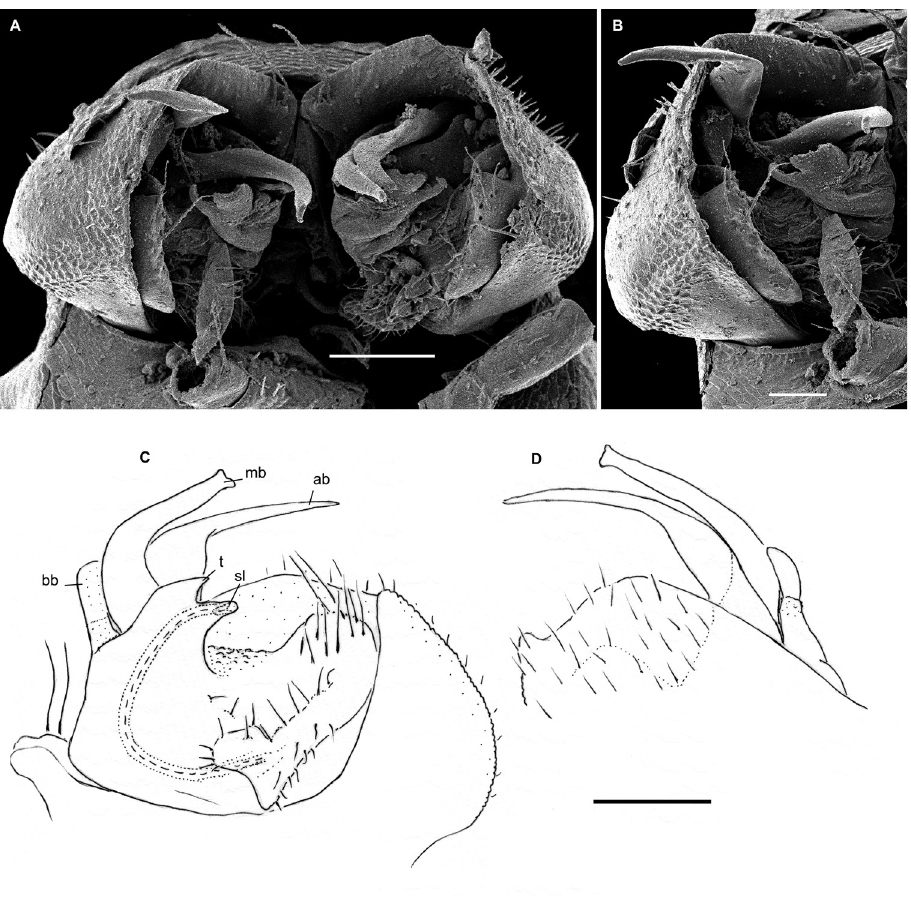
Figure 10. Hemisphaeroparia ongot sp. n. A ♂ paratype, SEM micrographs of both gonopods in situ, caudoventral view B ♂ paratype, SEM micrographs of right gonopod, caudoventral view C, D left go- nopod of holotype, mesal and lateral views, respectively. Scale bars: 0.1 mm ( A, C, D ), 0.05 mm ( B ). Abbreviations: ab apical branch of telopodite, bb basal branch of telopodite, lo lobe, mb medial branch of telopodite, sl solenomere, t